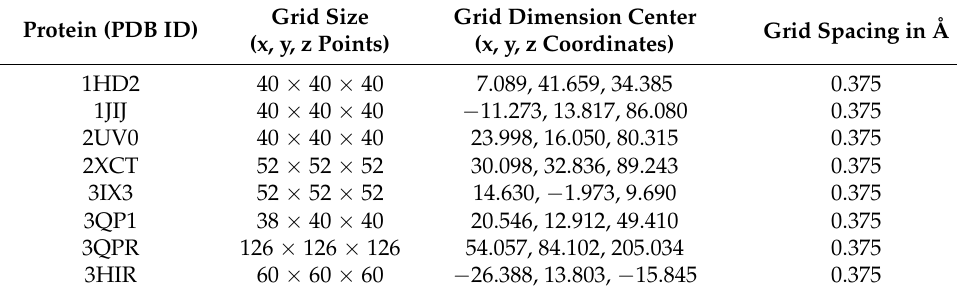
Table 8. Grid size and dimensions for the